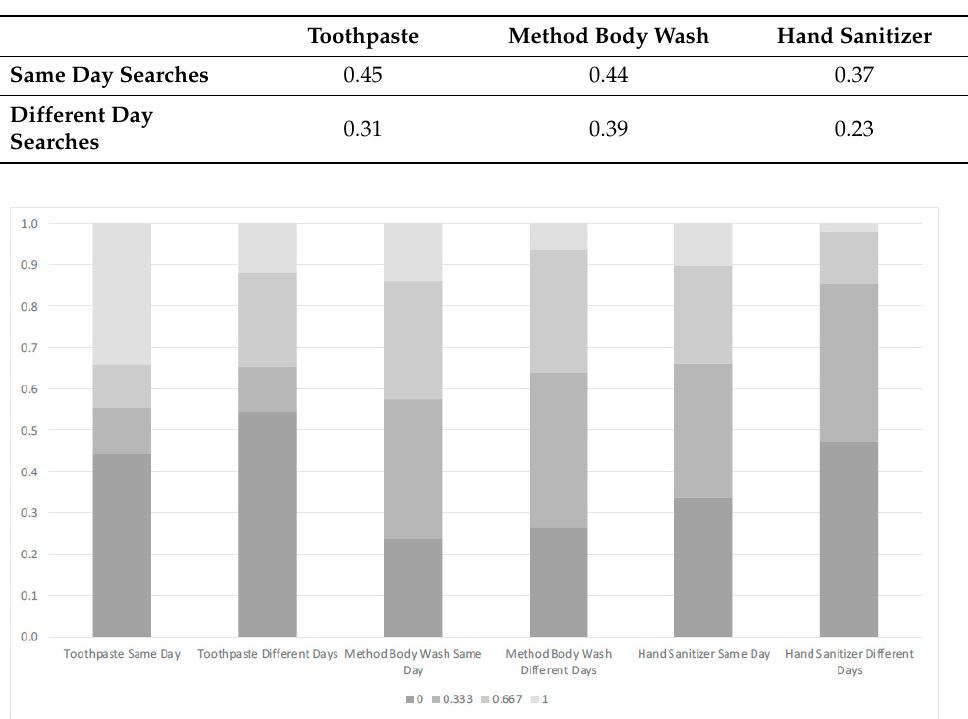
Table 5. Average overlap coefficient between the search results of each product for pairs of searches undertaken on the same day and pairs of searches undertaken on different days.